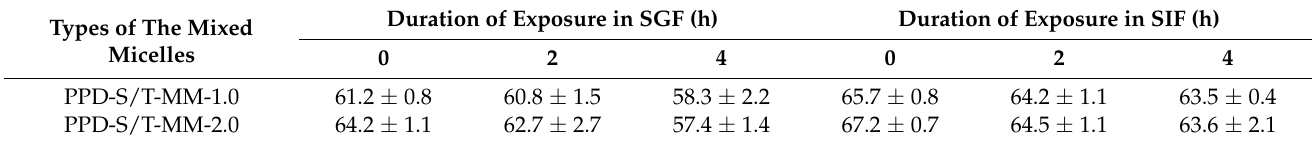
Table 5. Particle size of PPD-S/T-MM in SGF and SIF (nm, Mean ± SD, n = 3).